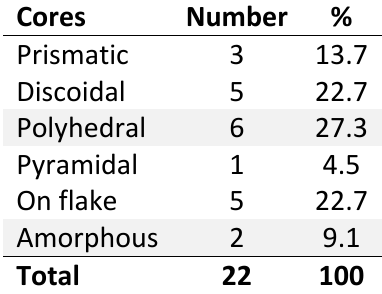
Table 4. Types of